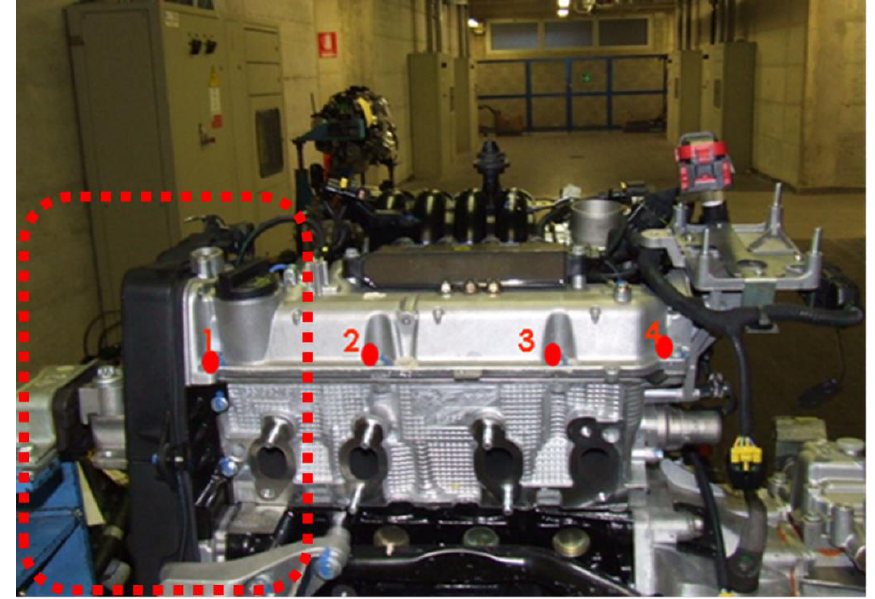
Figure 9. Experimental/numerical comparison in terms of displacements at the engine mount ( a ) with and ( b ) without consideration of the bracket (highlighted in Figure 3).